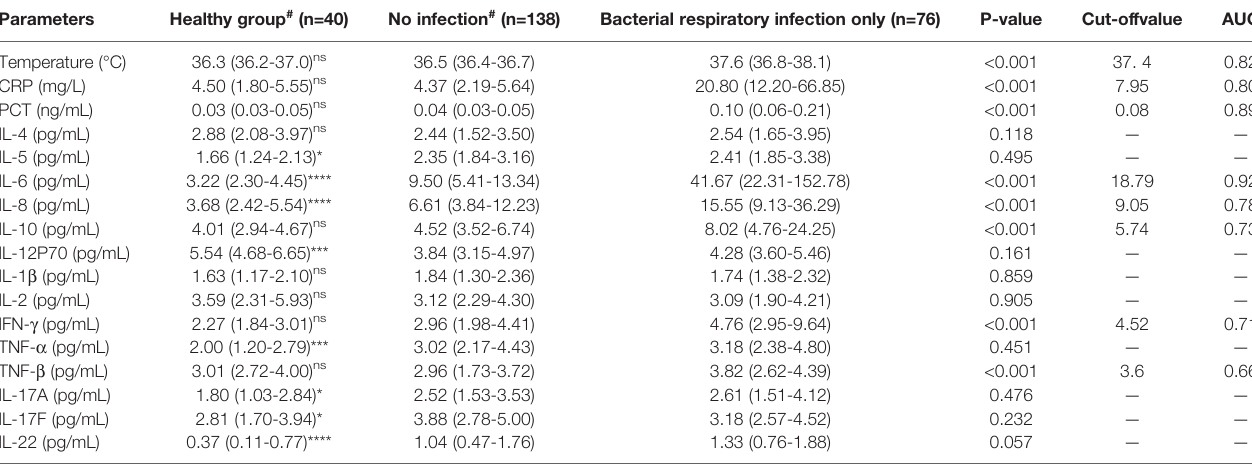
TABLE 2 | Comparison of serum CRP, PCT and cytokine levels in NHL patients with or without bacterial respiratory infection.